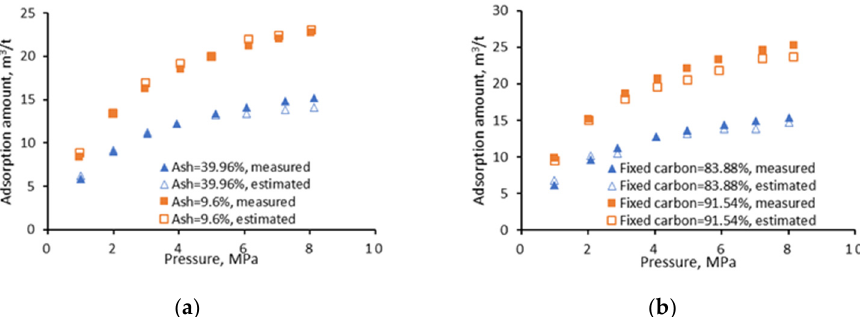
Figure 7. Comparison of the estimated with measured adsorption isotherms for samples with ( a ) ash contents of 9.6% and 39.96%, respectively, and ( b ) fixed carbon contents of 83.88% and 91.54%, respectively.